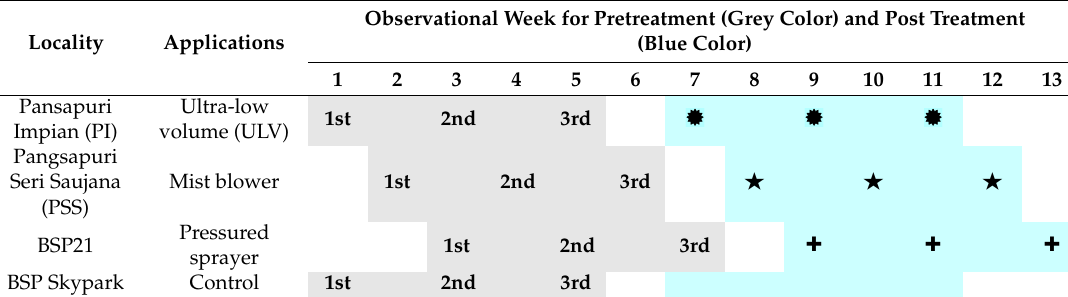
Table 1. Timeline of the study on the efficacy of Bti treatment on Aedes sp. using different applications at high-rise buildings.